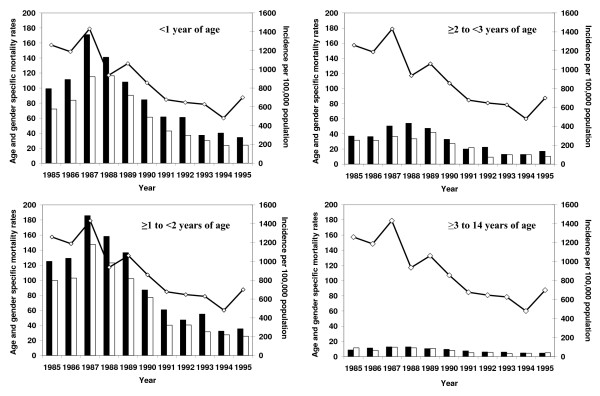
Acute viral hepatitis-associated mortality rates for children in various age groups, and reported acute viral hepatitis incidence in all age groups, per 100,000 population, by year, Uzbekistan, 1985–1995. Left ordinate (y-axis) and bar diagram: age- and gender-specific mortality: "black bars" – mortality among boys; "white bars" – mortality among girls, per 100,000 population of corresponding age and sex. Right ordinate (y-axis) and line diagram: reported acute viral hepatitis incidence in the general population, per 100,000.